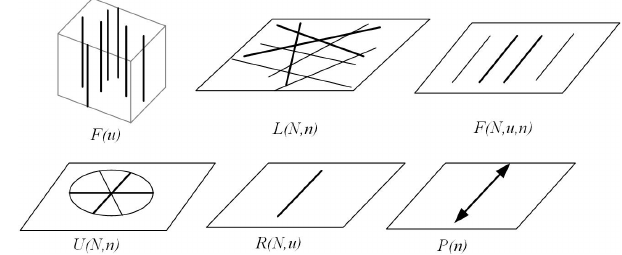
Figure 2. Fundamental building blocks.